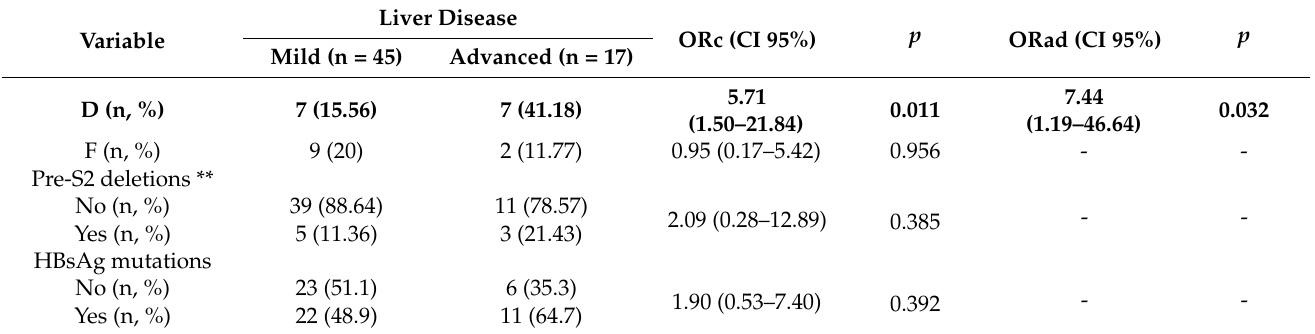
Figure 3. ( A ) Molecular docking between HBV-RO-10 and the heavy chain of the Fab fragment of antibody 6VJT (anti-HBs); ( B ) Site of interaction between the chains of the two proteins is high- lighted; ( C ) Plot of hydrogen bonds (blue lines), nonbonded contacts (orange tick marks), and salt bridges (red lines) between residues on either side of the protein–protein interface. Images gener- ated with PyMOL© and PDBSum©. 4. Discussion This study provided the most comprehensive molecular characterization of HBV iso- lates circulating in Rondônia, Brazil, to date, including samples from the capital and rural